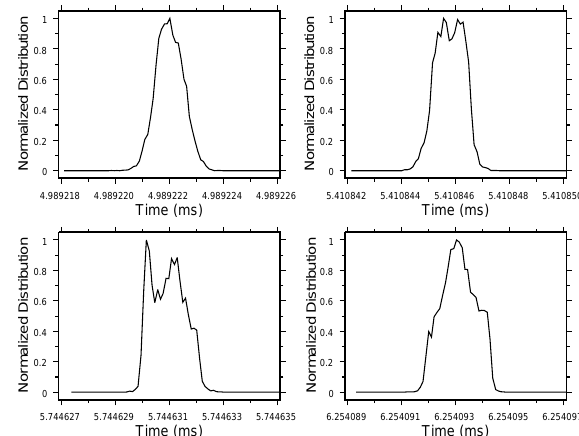
FIG. 7. Bunch distributions in ELEGANT simulations of SURF, just before, during, and after the blowup due to the instability, starting from the upper left. The time delay from the first to the second plot (upper right) is 0.4 ms, to the third (lower left) is 0.75 ms, and to the last (lower right) is 1.26 ms. The third plot especially shows high-frequency structure during the second mini blowup. The bunch elongation due to the blowup in the model was on the order of 50% whereas a factor of approximately 2 was actually